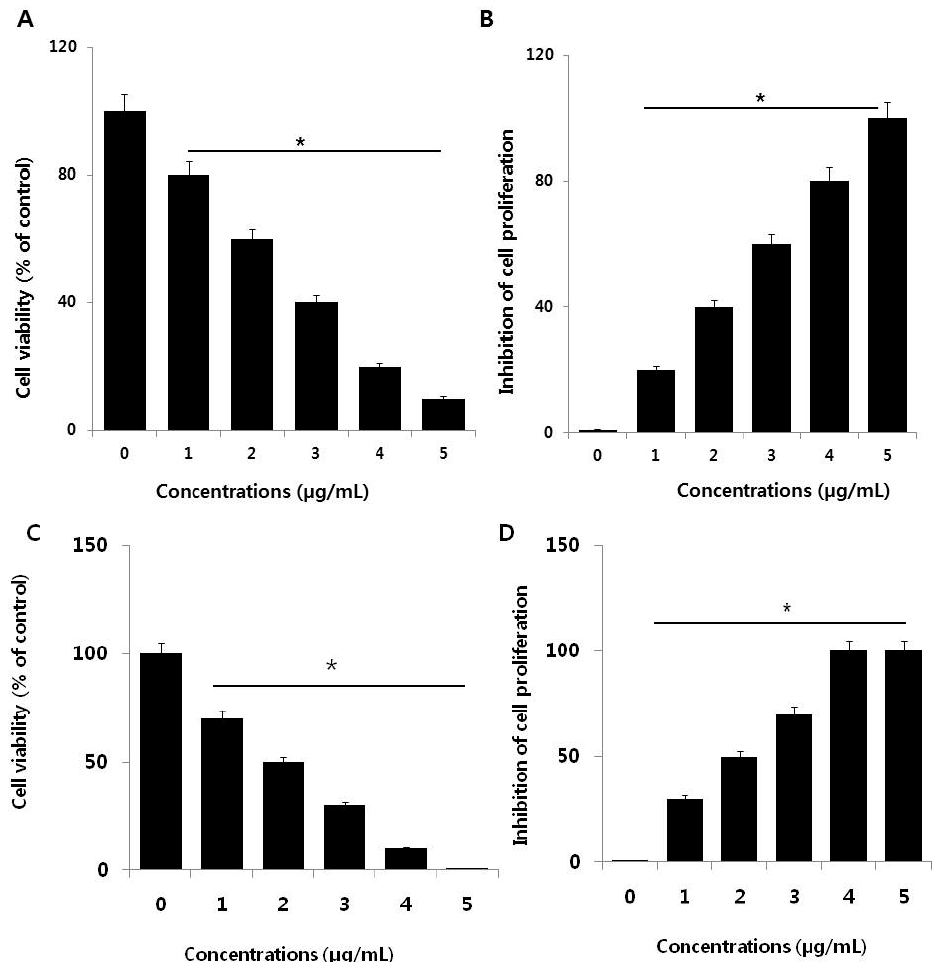
Figure 2. Effect of palladium nanoparticles (PdNPs) on SKOV3 cell viability and proliferation. ( A ) Viability of SKOV3 cells was determined by CCK-8 assay after a 24-h exposure to different concentrations of PdNPs. ( B ) The cell proliferation assay was performed using BrdU incorporation. A significant difference was observed between treated and untreated cells. Effect of palladium ions on SKOV3 cell viability and proliferation. ( C ) Viability of SKOV3 cells was determined by CCK-8 assay after a 24-h exposure to different concentrations of Pd ions. ( D ) The cell proliferation assay was performed using BrdU incorporation. A significant difference was observed between treated and untreated cells.